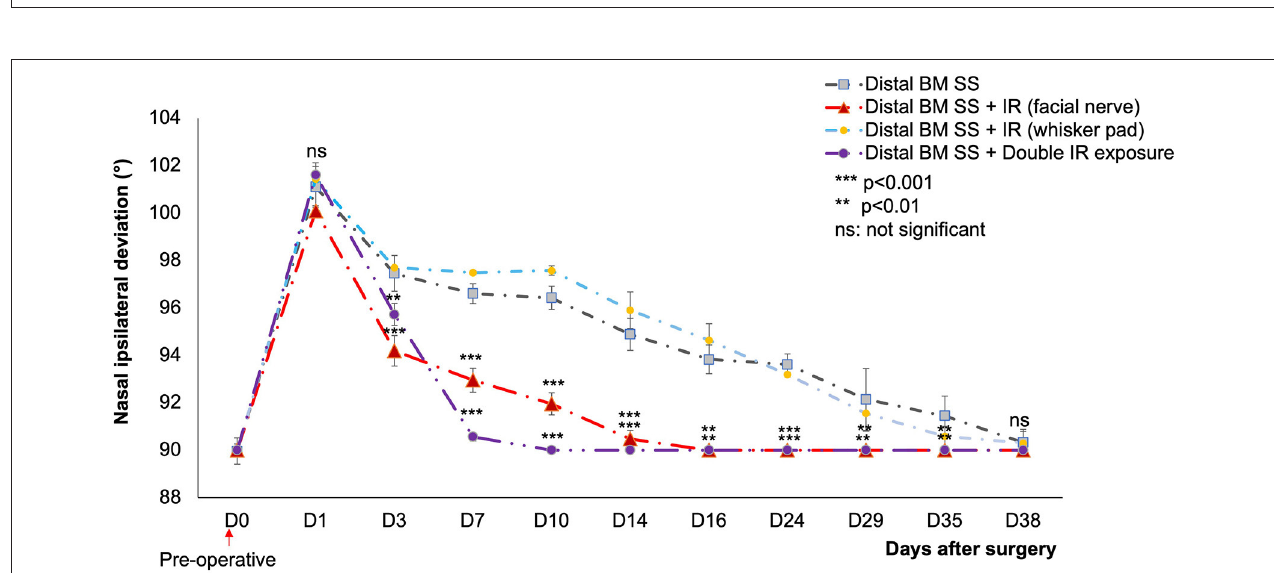
FIGURE 4 | Mean nasal deviation ( ◦ ) in the different groups, for D0 to D38. The initial nasal position was recovered on day 7 (double IR exposure) and D16 (single IR exposure) only for IR-treated mice ( p < 0.001) and ( p < 0.01) respectively compared to control. No significant difference was observed between the control and the IR treated group (at the ipsilateral whisker pad) ( p > 0.05). : distal SS of the buccal and marginal mandibular branches without treatment ( n = 12). : distal SS of the buccal and marginal mandibular branches with IR treatment at one site (facial nerve suture) ( n = 12). : injured nerve (distal SS of the buccal and marginal mandibular branches) with IR treatment at the ipsilateral whisker pad ( n = 6). : injured nerve (distal SS of the buccal and marginal mandibular branches) with two irradiated areas: (1) injured area of the facial nerve, and (2) corresponding whisker pads on the ipsilateral side. Distal Pes SS: injured nerve without treatment ( n = 6). [**( p < 0.01) ***( p < 0.001); t test].